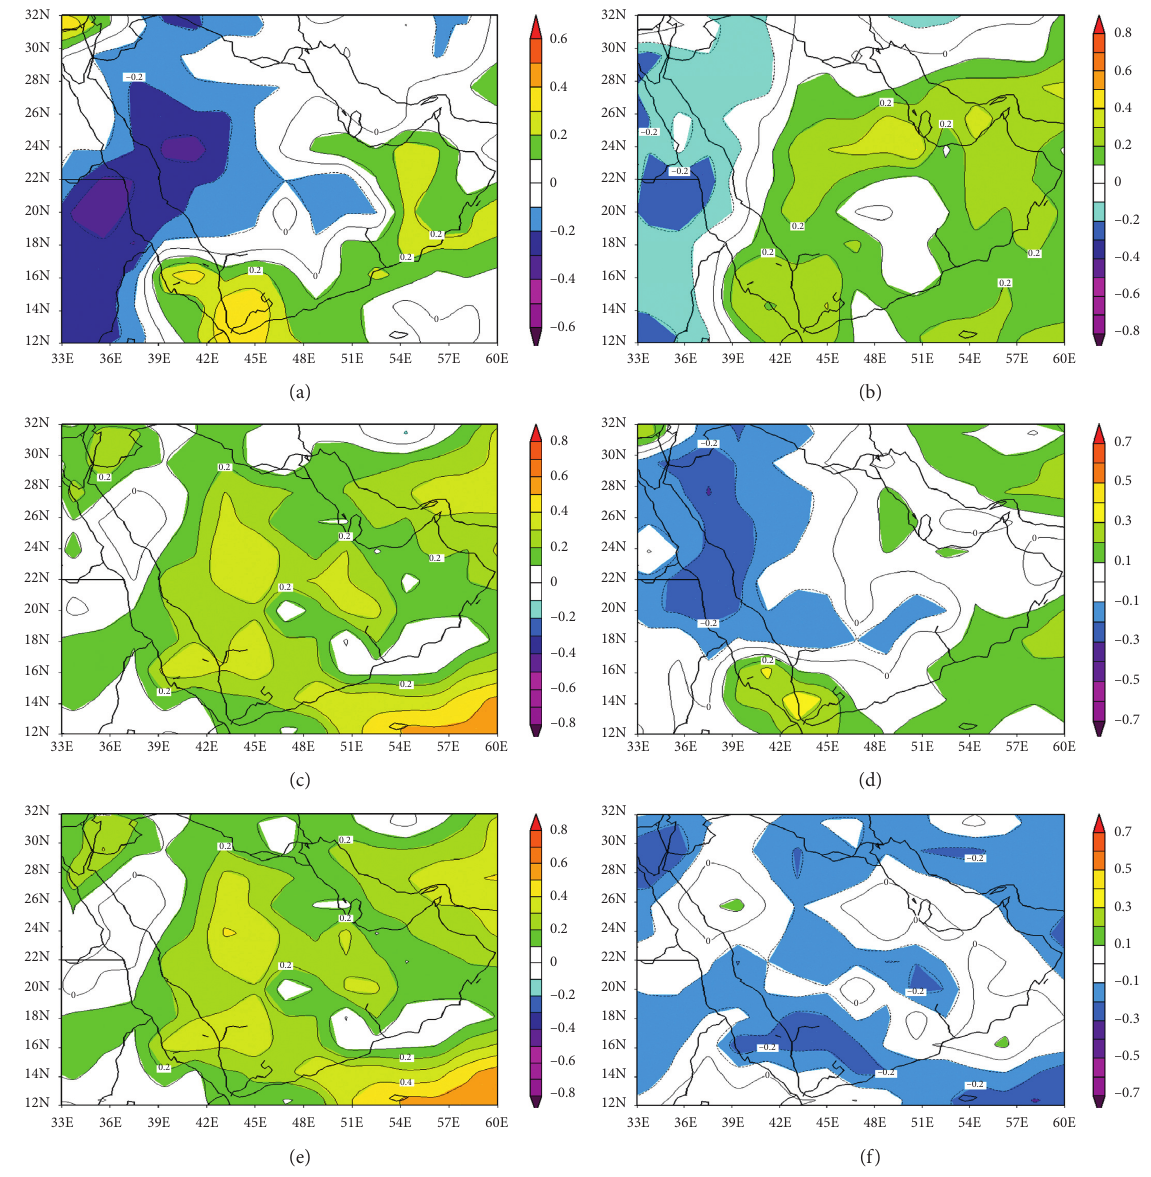
Figure 8: The distribution of the correlation coefficients between the PR over the Arabian Peninsula, including SA, and the climatic indices for November during the study period (1948–2018). (a) AO. (b) GSAT. (c) MEI. (d) NAO. (e) Nino 3.4. (f) SOI (NCEP/NCAR Reanalysis NOAA/ESRL Physical Sciences